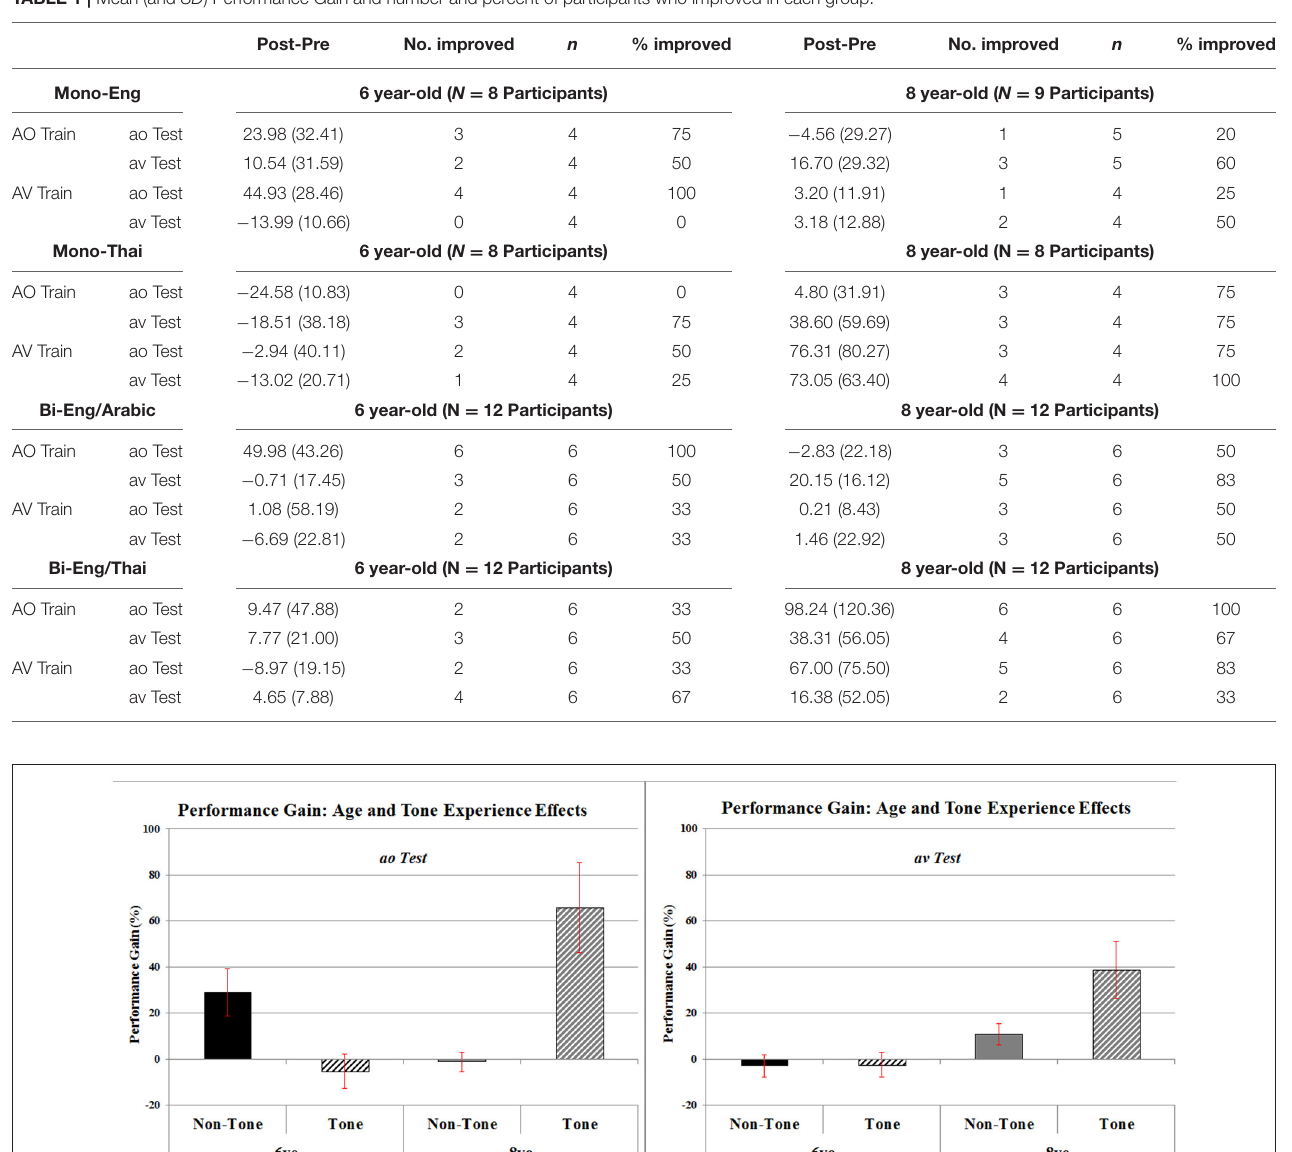
deletion task, is positively related to their initial identification of the four Mandarin tones presented in auditory-visual